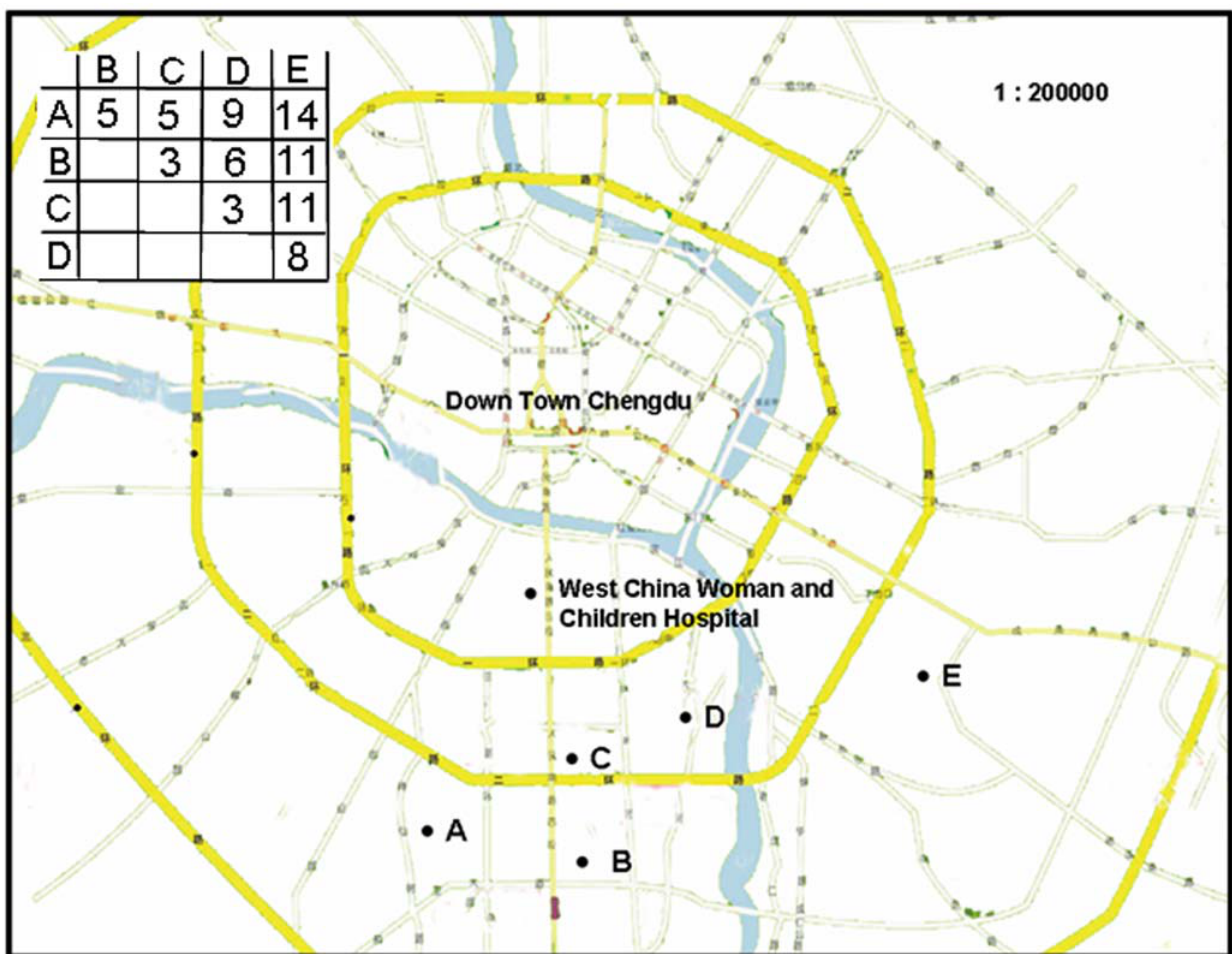
Figure 2. Map showing the locations of theWest ChinaWoman and Children Hospital (where the invasive samples were recovered),and five kindergartens A, B, C, D and E, where carriage samples were recovered. The inset shows the distances (in Km) between the kindergartens.